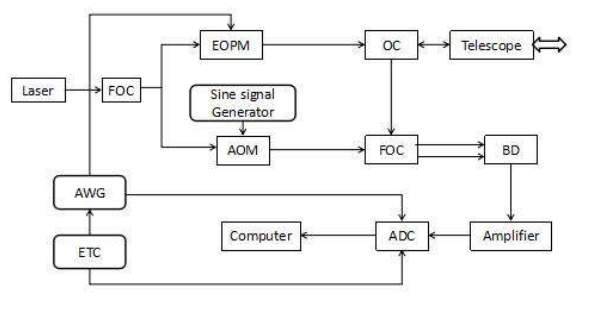
Figure 1 A schematic view of the